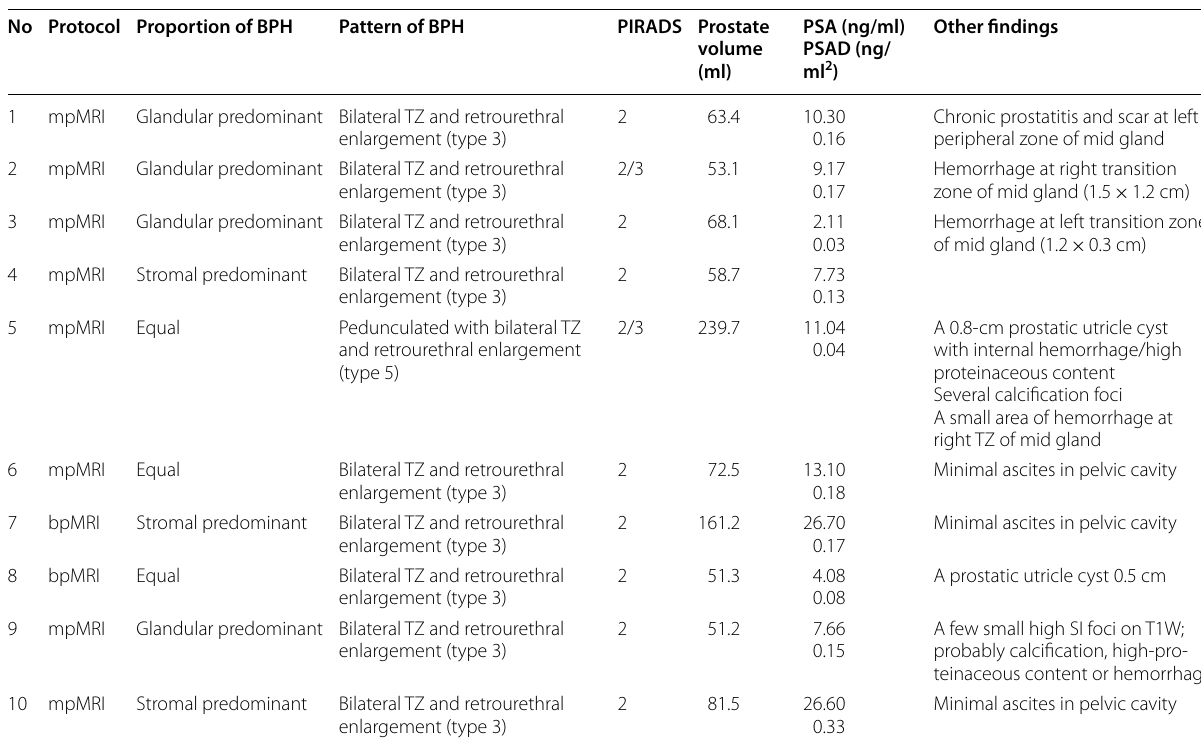
Table 4 MRI features of all patients in the study No Protocol Proportion of